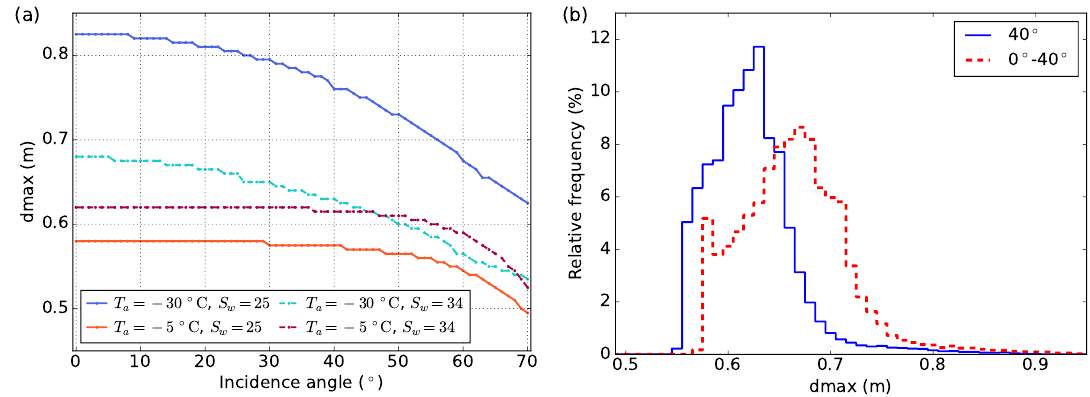
Figure 12. ( a ) theoretical dependency of d max on incidence angle for different cases with constant water salinities and air temperatures at 2m height assuming a wind speed of 5m/s during polar night; ( b ) histogram of SMOS saturation thicknesses d max retrieved using TBs at near-nadir (0 ◦ –40 ◦ ) and at θ = 40 ◦ during the considered winter season (15 October 2015–15 April 2016) in the